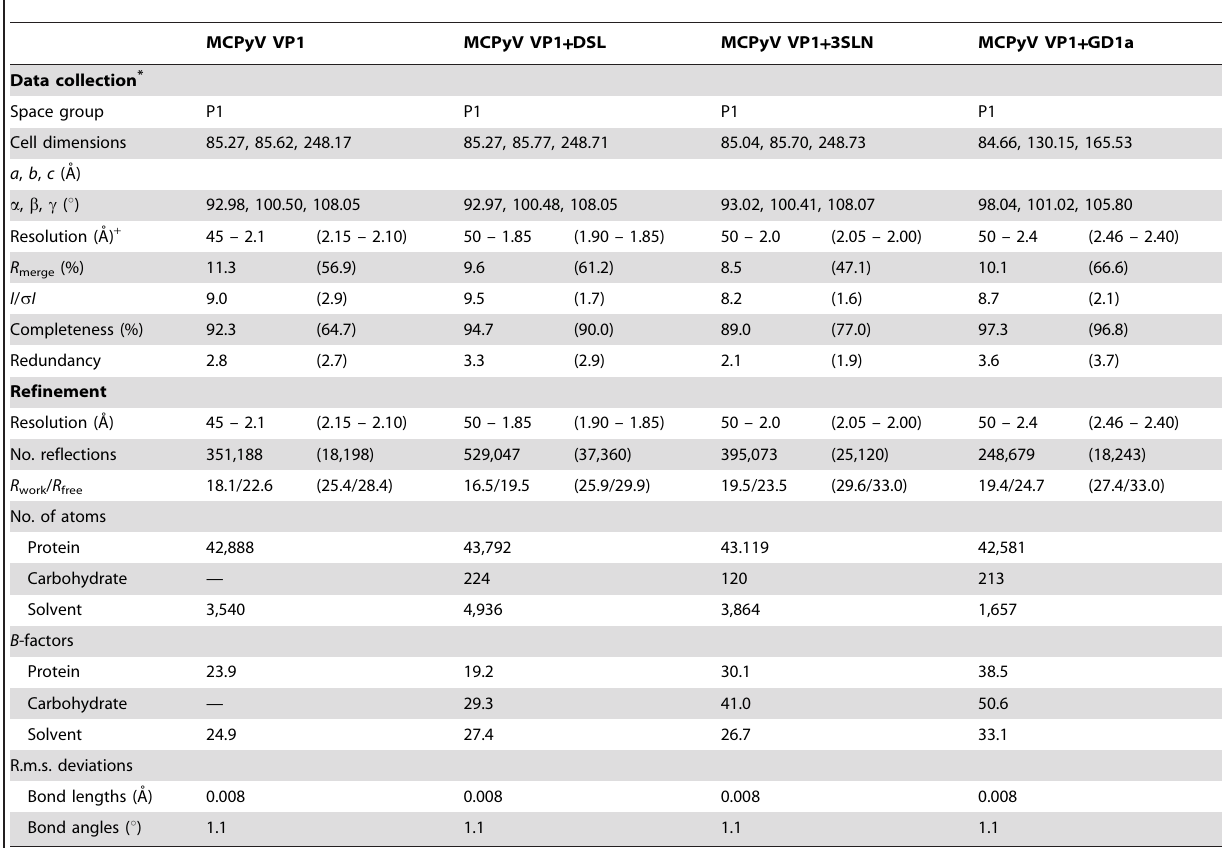
Table 1. Data collection and refinement